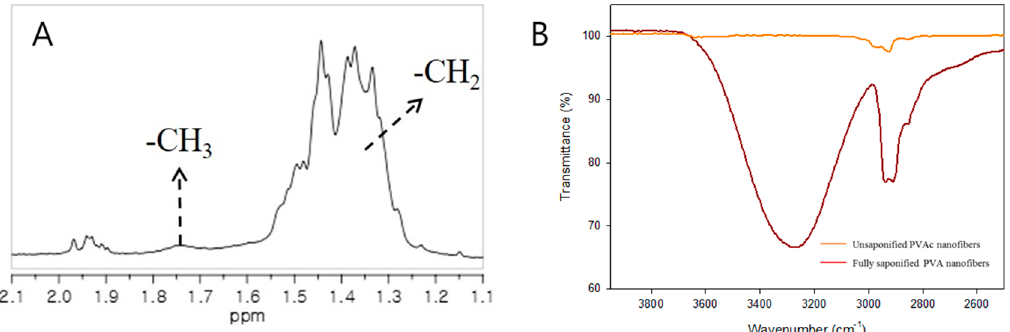
Table 3. Molecular weights of generally electrospun PVA nanofibers and saponified PVA nanofibers with DS of 99.9% [24], as determined by gel permeation chromatography.